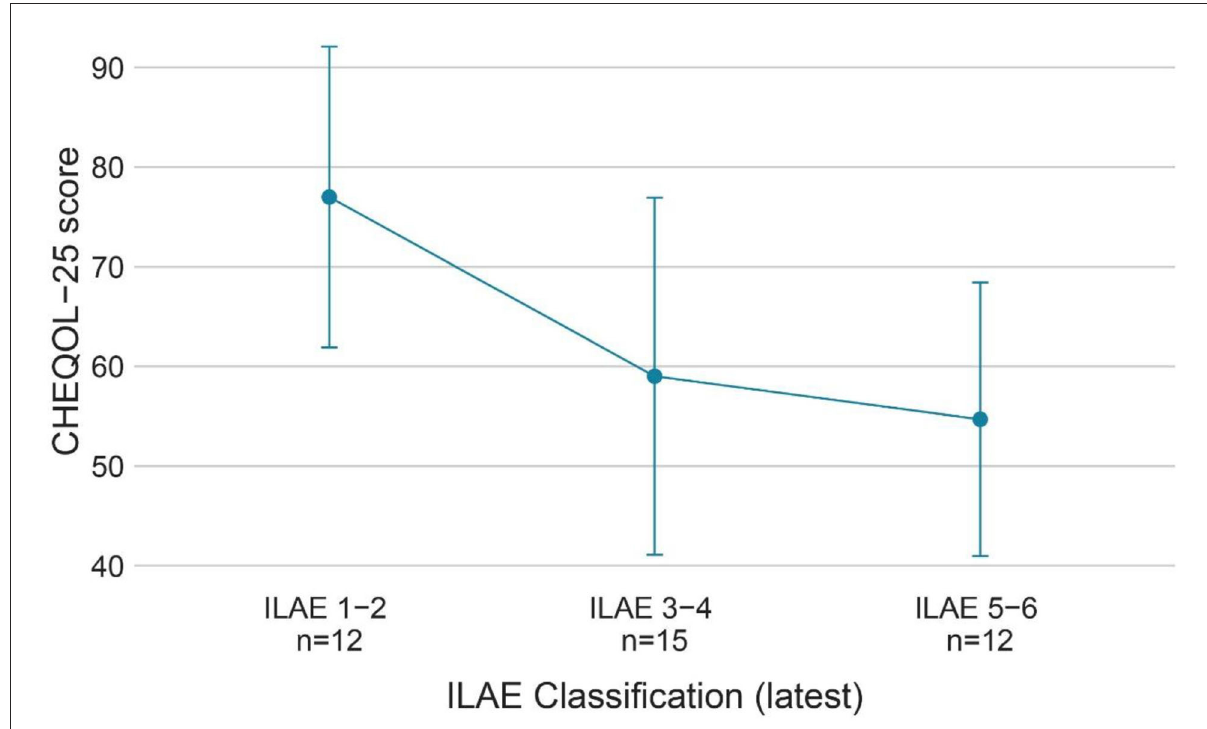
FIGURE5 QoL (CHEQOL-25 total score) group means ( ± standard error) of patients with different ILAE seizure outcome classifications (latest). QOL, quality of life; ILAE classification, International League Against Epilepsy seizure outcome classification.